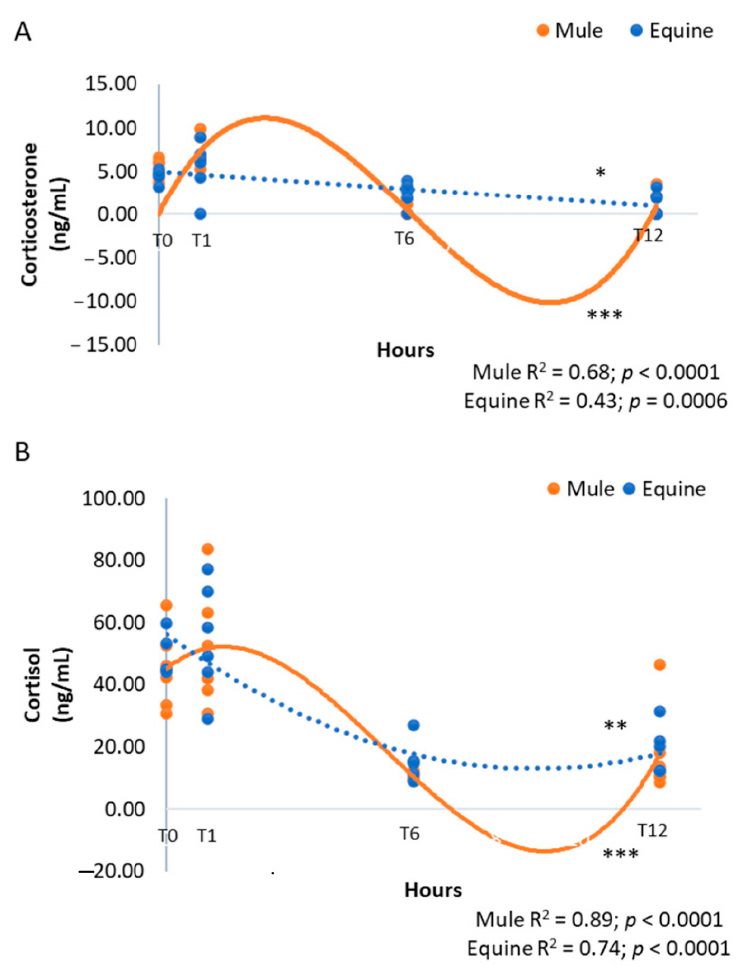
Figure 3. Corticoid concentrations of corticosterone ( A ) and cortisol ( B ) (ng/mL) in neonatal mule ( n = 6, solid lines) and equine ( n = 6, dashed lines) foals at birth (immediately after expulsion–T0), and at 1 (T1), 6 (T6) and 12 h after birth (T12). Results represent the mean. * Linear, ** quadratic and *** cubic effects are shown with R 2 and p